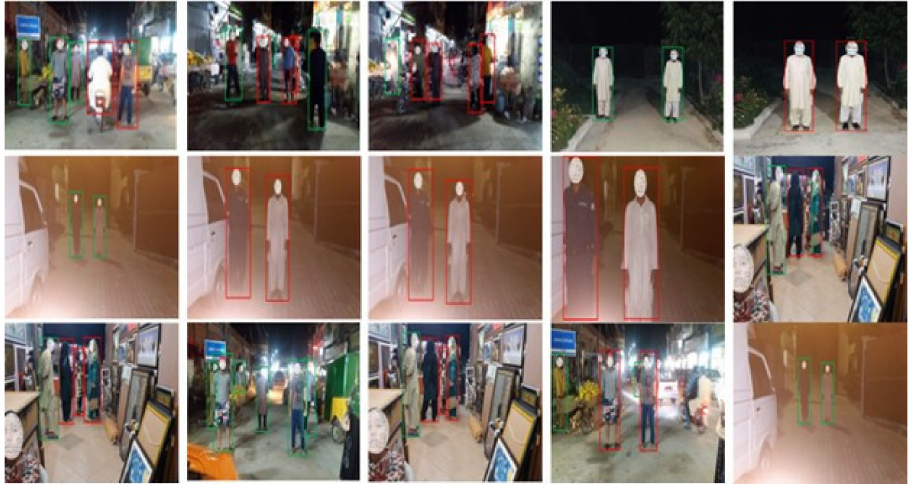
Figure 9. Qualitative visualisations of the DepTSol model on some testing dataset seeds under different low-light